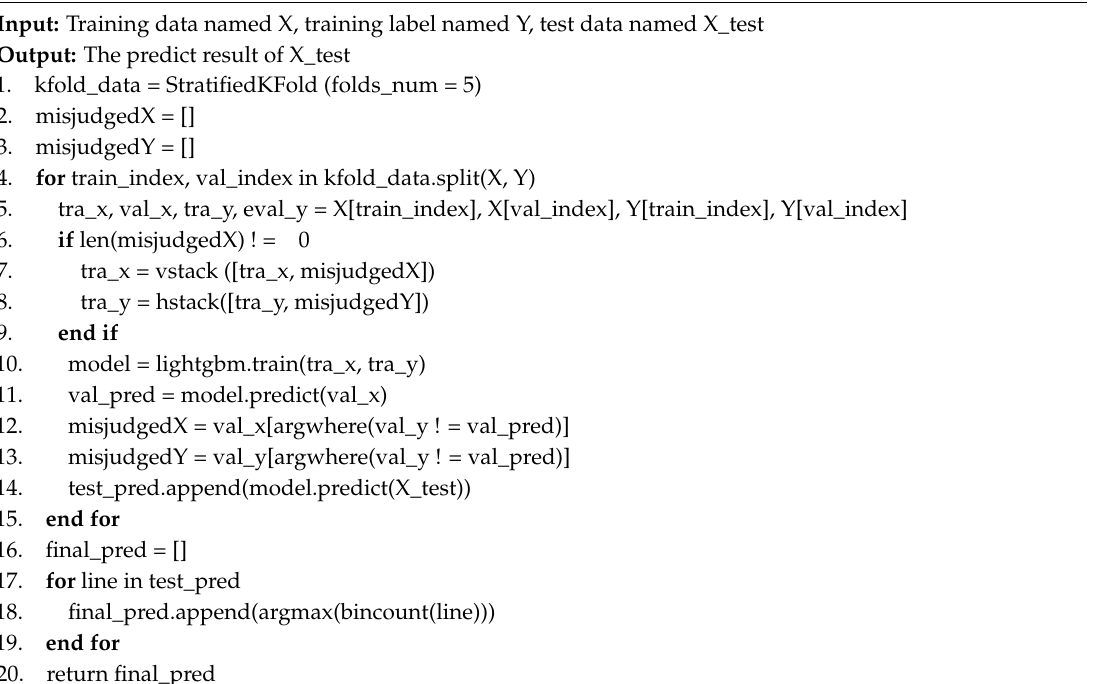
Algorithm 2: Supervised Feature Classification